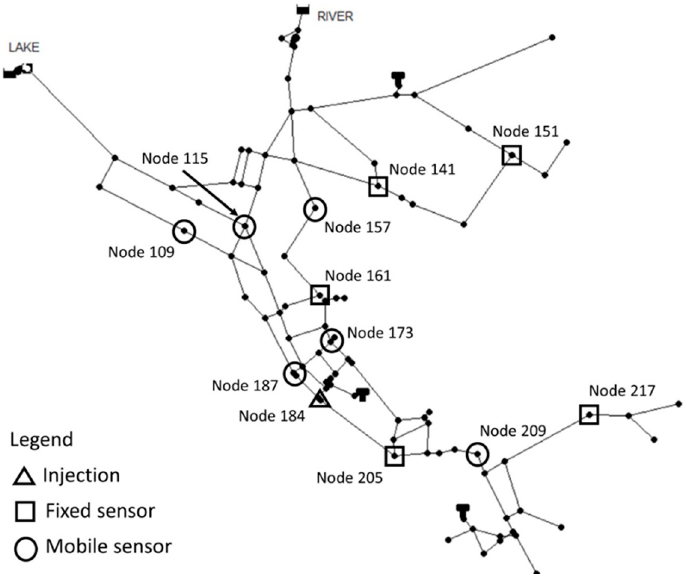
Figure 4. EPANET network example application, Net3, including the position of the placed mobile sensors, the injection node of the contamination injection as well as the fixed sensor that initially detected the contamination.